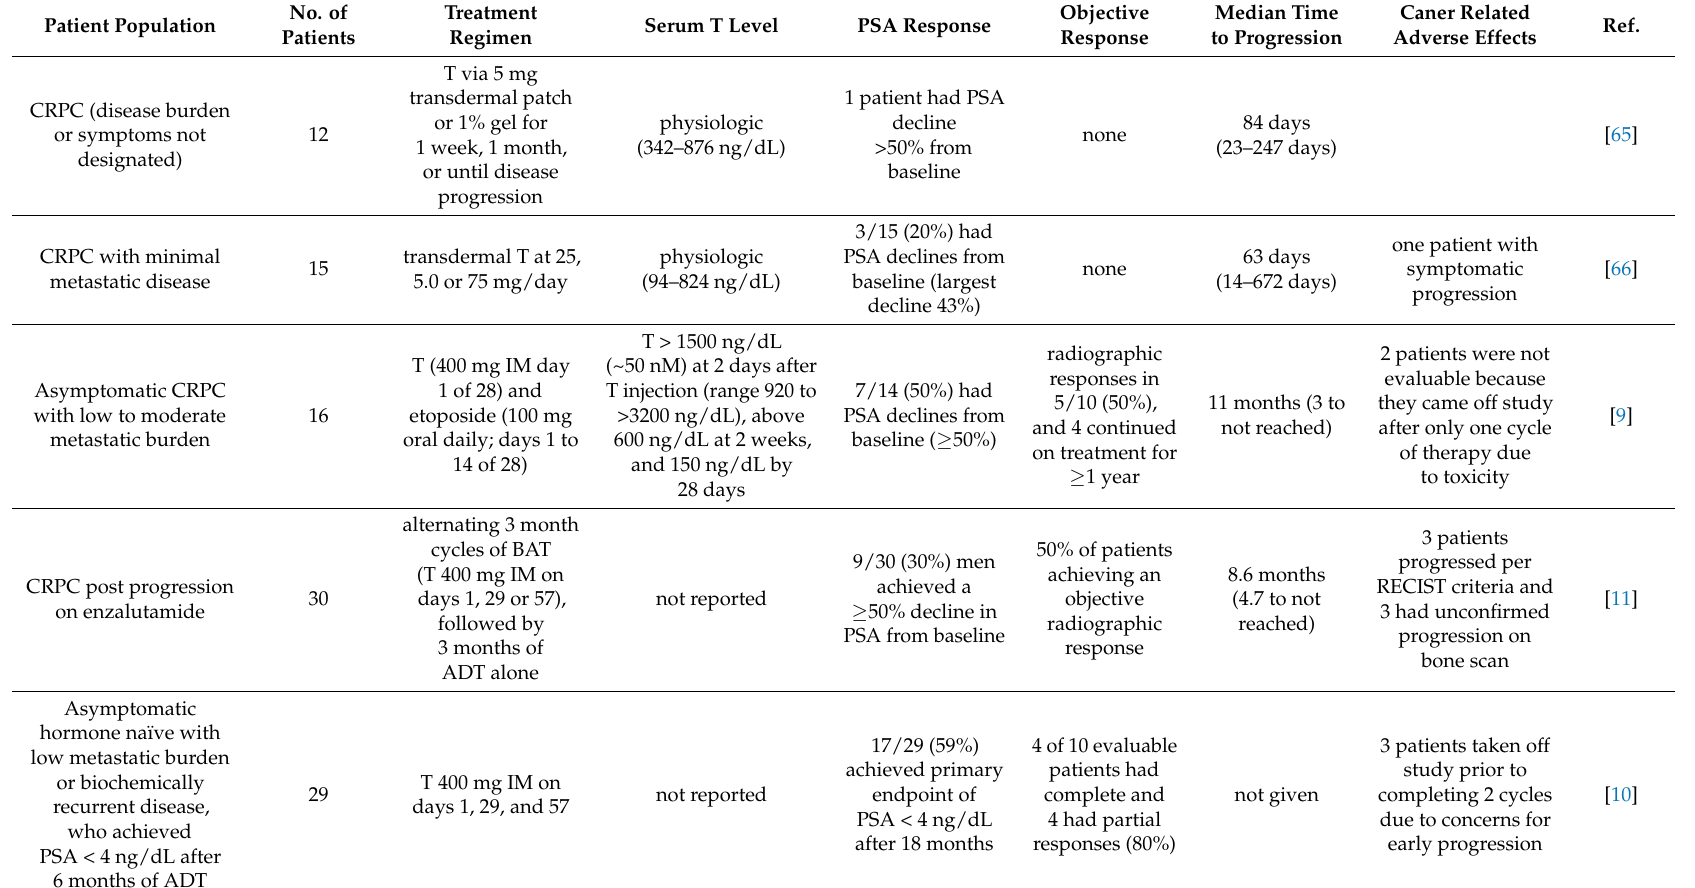
Table 1. Contemporary Trials of High Dose Androgen